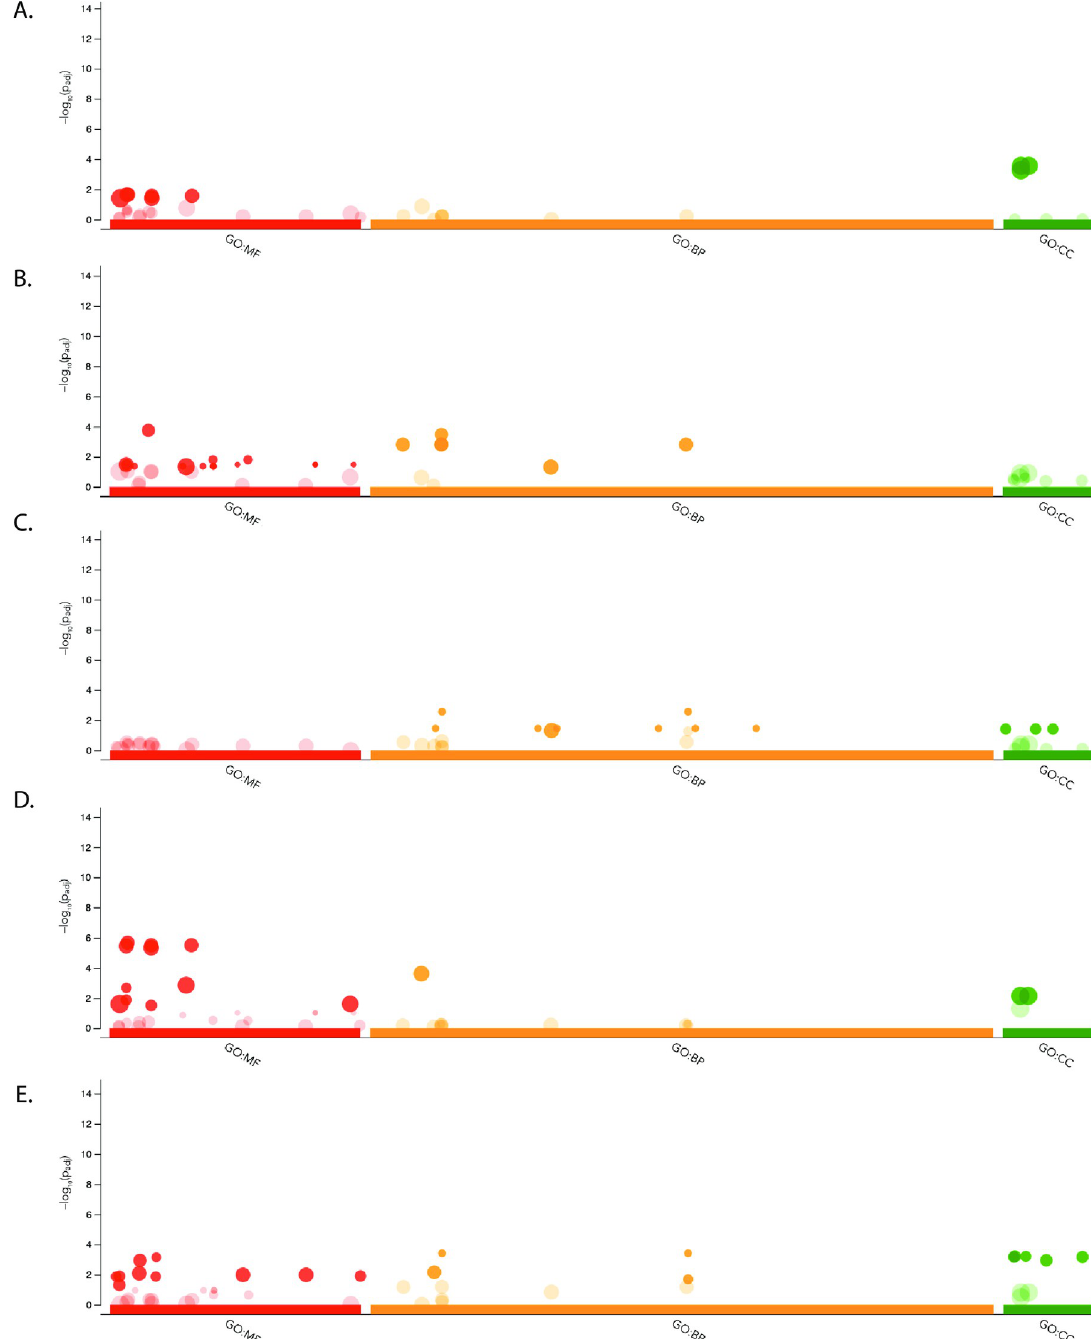
Fig 4. Results of g:Profiler analysis on differentially expressed transcripts in each contrast considered. Y-axis is -log10 transformed P values, and X-axis are GO categories for molecular function (MF), biological process (BP), and cellular component (CC) with the number of significant categories with FDR < 0.05 in parenthesis next to each category. Points that are transparent are those that are not significant with FDR > 0.05. Displayed are 2 dpi (A.), 7 dpi (B.), 14 dpi (C.), 2 to 7 dpi (D.), and 7 to 14 dpi (E.).